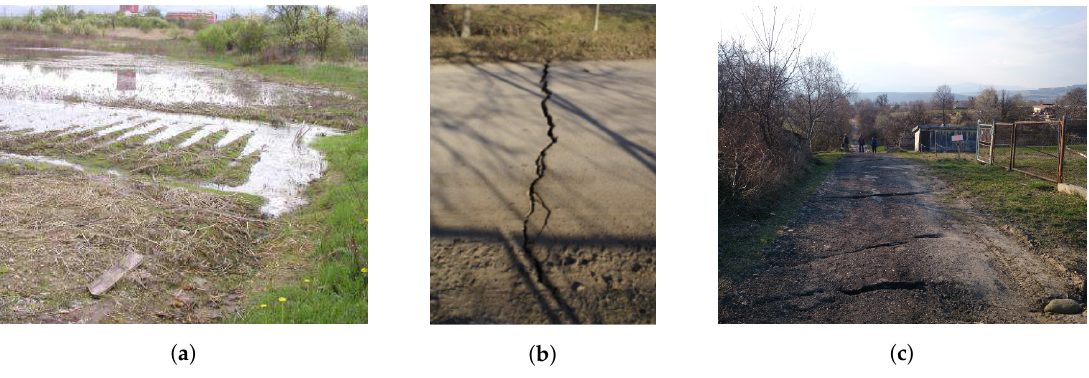
Figure 15. Consequences of Kos village subsidence: ( a ) Formation of wetlands (April 2004); ( b ) Infrastructural damage (December 2016), ( c ) Geomorphological changes (March